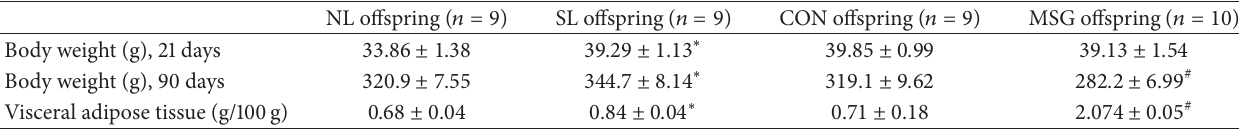
Table 3: Body weight and visceral adipose tissue in adult SL and MSG